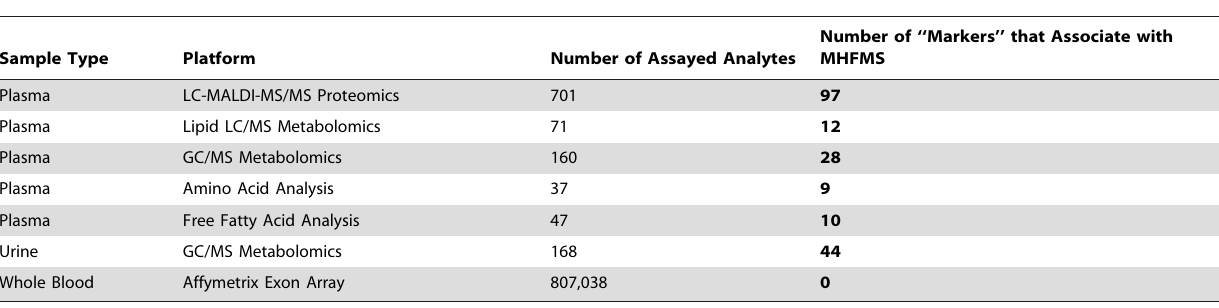
Table 3. Results from primary outcome analysis across all seven ‘‘omic’’